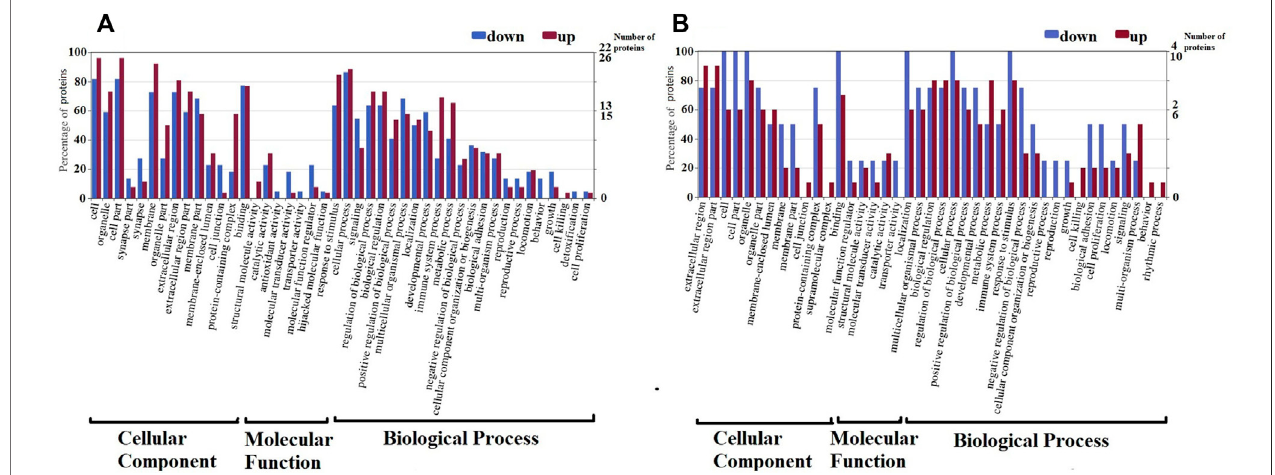
FIGURE 2 | G ene Ontology (GO) classi fi cation of differentially expressed proteins by label-free quantitative proteomics experiments between RRMS and ONIND (Fold change = 1.5). The differentially expressed proteins are grouped into three hierarchically structured GO terms: biological process, cellular component, and molecular function in CSF (A) and serum (B) . The y -axis indicates the number and percent of proteins in each GO